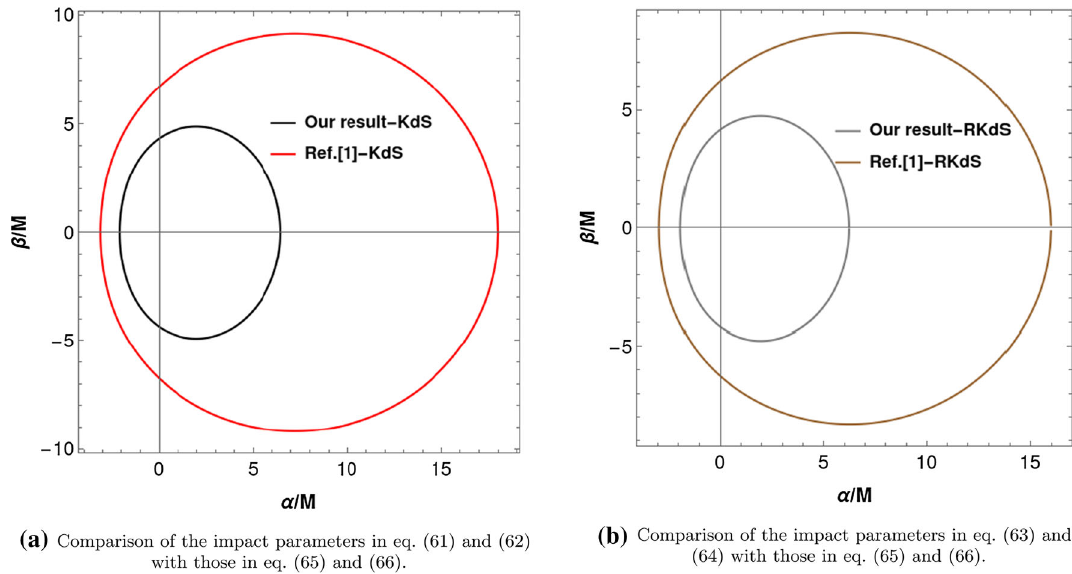
Fig. 4 Illustration of the discrepancy between our result and Ref. [1]. (cid:2) = 0 . 06 m − 2 , M = 1 . 06, θ = π/ 2, and a = 0 . 999